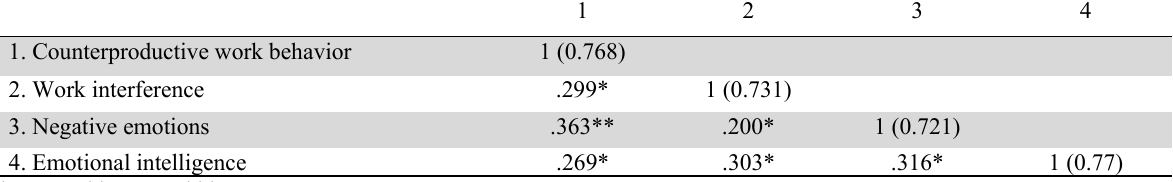
Correlation and Reliability Analysis